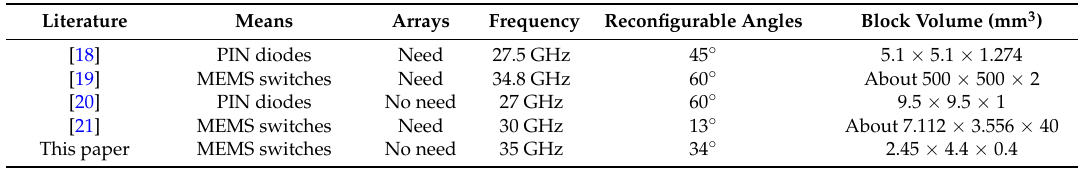
Table 3. Performance comparison of the proposed antenna with available